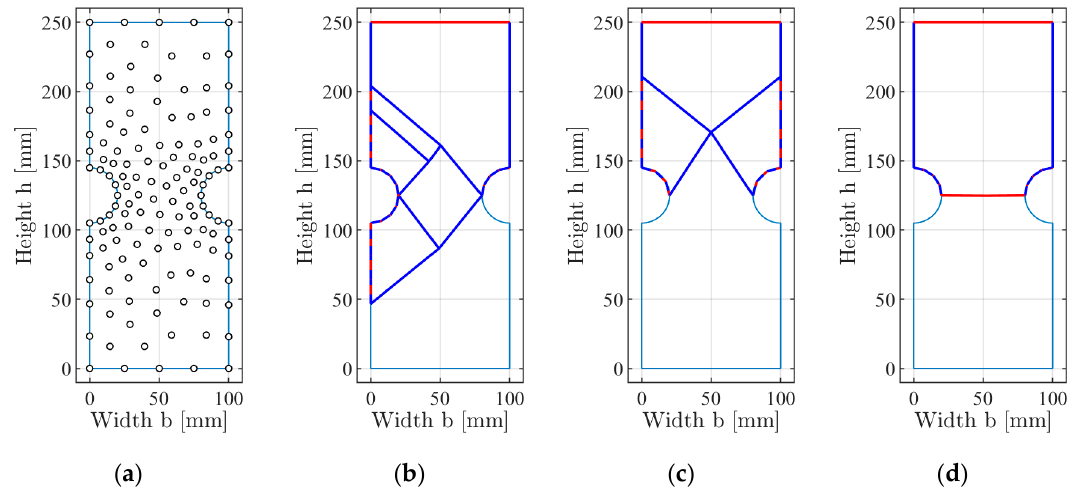
Figure 10. Collapse mechanisms (blue: Slip displacements, red: Normal displacements) from DLO for the tensile specimen with notches: ( a ) Nodes; ( b ) asymmetrical slip line mechanism; ( c ) symmetrical slip line mechanism; ( d ) yield zone mechanism.